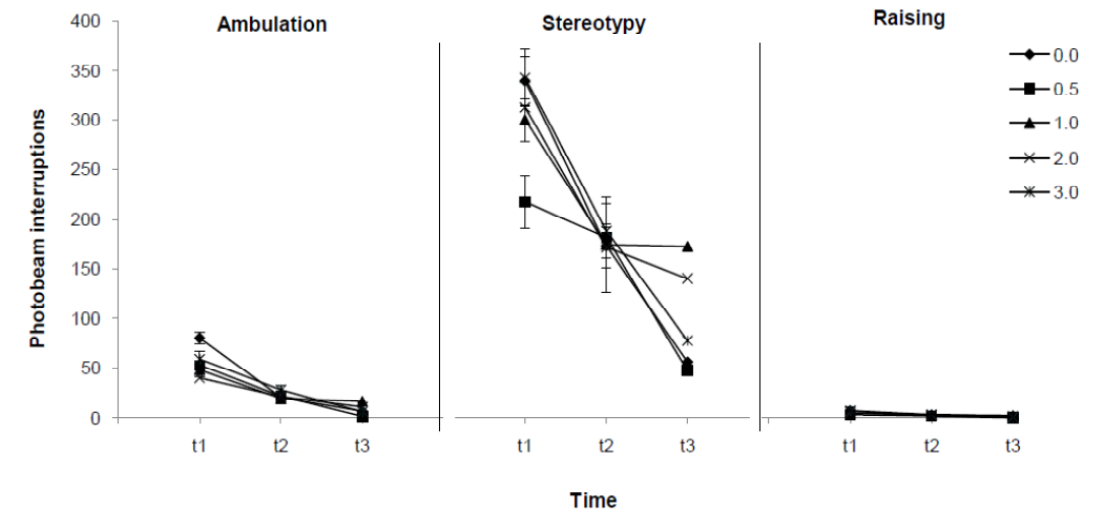
Figure 5. Effect of indanamide ( 3 ) on ambulation, stereotypy and raising episodes. Data represent means (±SE) of photobeam interruptions during 60 (t1), 120 (t2) and 180 (t3) minutes after administration of 0.0, 0.5, 1.0, 2.0 and 3.0 mg/kg for each activity topography (ambulation, stereotypy and raising episodes). MANOVA showed that time, but not drug effects, was dependent on topography. Bonferroni post-hoc test indicated that stereotypy and ambulatory episodes decreased over